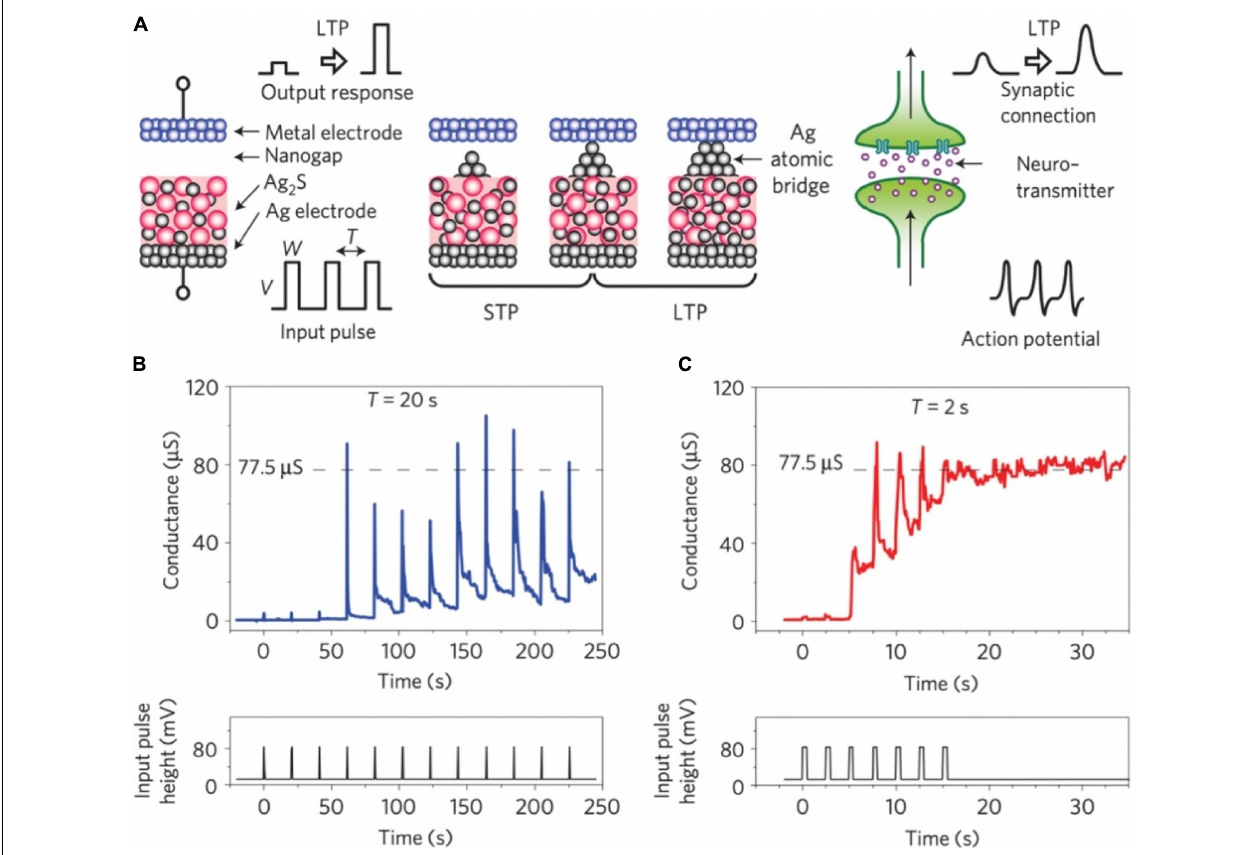
FIGURE 3 | (A) Schematic diagram of Ag 2 S inorganic synapse and the formation mechanism for STP and LTP. Right side: The signal transmission of biological synapse. (B,C) STP and LTP characteristics of the Ag 2 S inorganic synapse when input pulses were applied with the intervals of 20 and 2 s (adapted from Ohno et al., 2011).